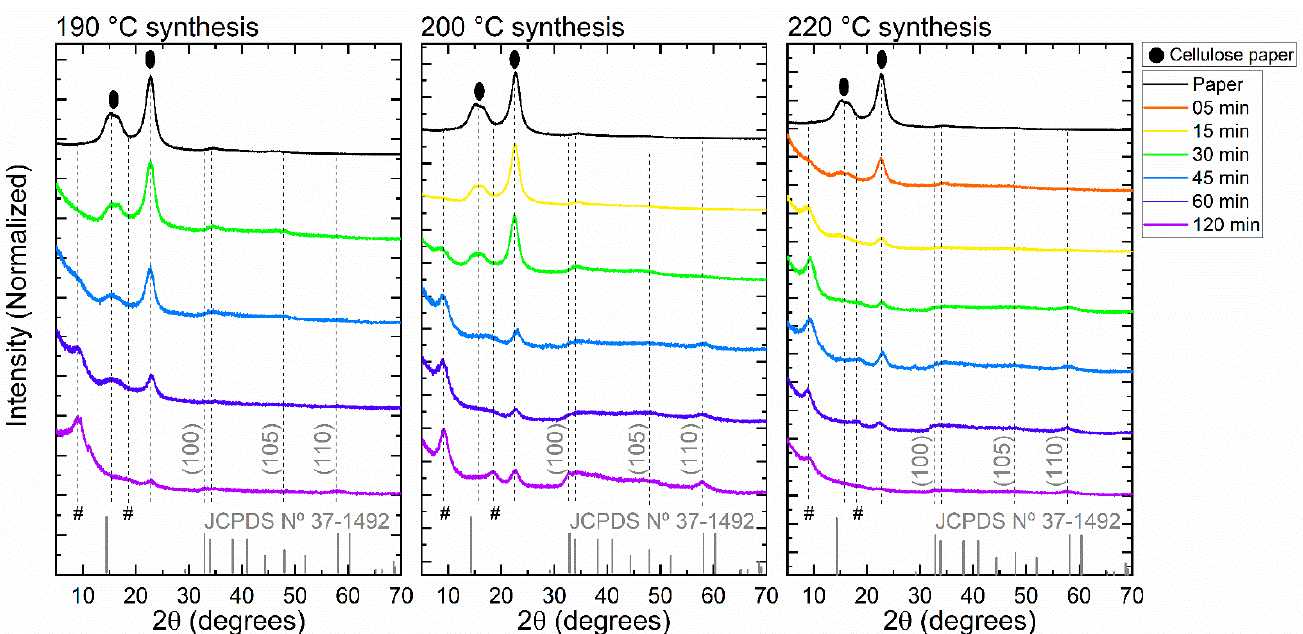
Figure 3. X ‐ ray diffraction patterns of MoS 2 nanosheets growth on cellulose paper substrate at different synthesis temperatures and times and the JCPDS 37 ‐ 1492 card pattern of 2H ‐ MoS 2 . The peaks identified by circles are related to the cellulose paper. The # symbol is used to identify the peaks at 9.3° and 18.6°.